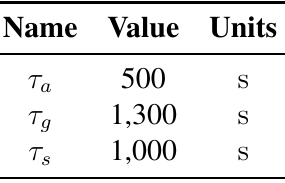
Table 3. Tuned measurement standard deviations for R and R